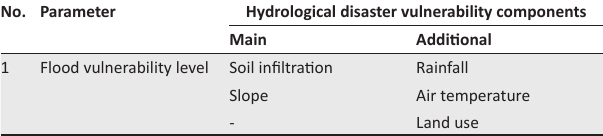
TABLE 9: Classification of flood vulnerability levels based on the Krueng Jreue Sub-Watershed area. Classification